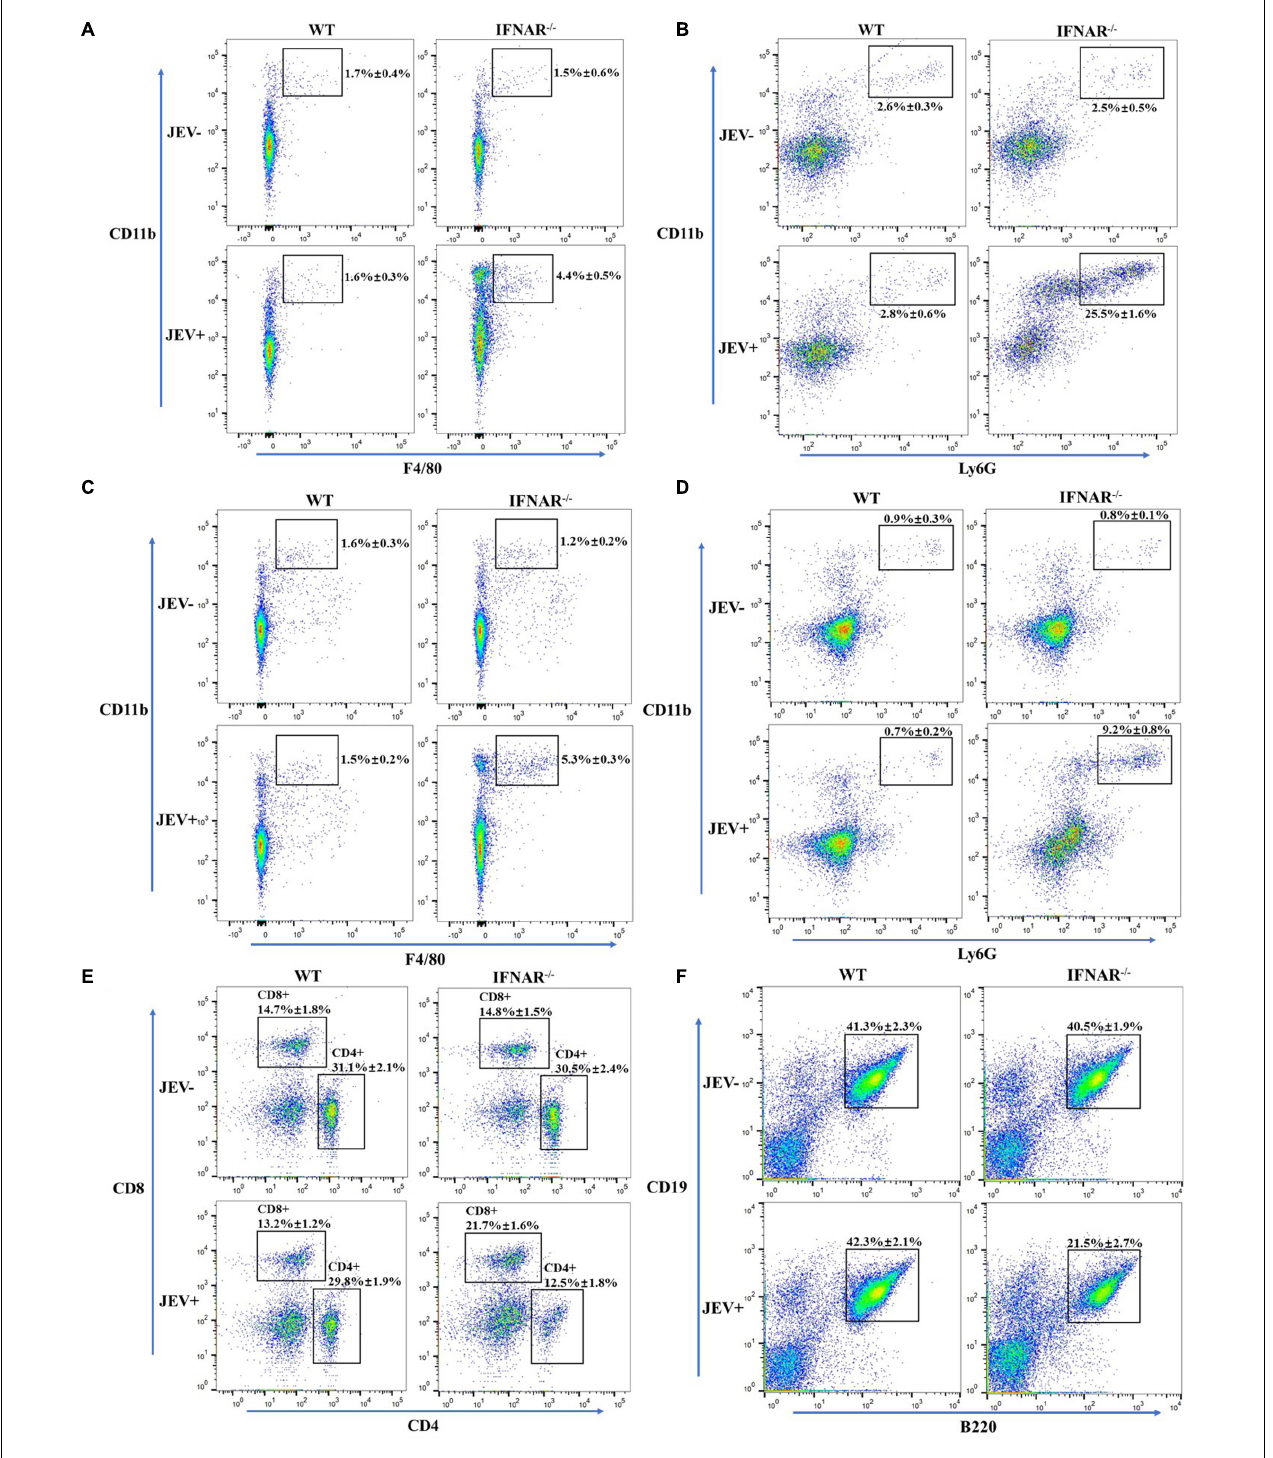
FIGURE 7 | Inflammatory cells infiltrate the liver and spleen in response to the SA14-14-2 strain. Flow cytometry was performed on cells isolated from the liver and spleen of SA14-14-2 strain infected IFNAR − / − mice at 4 dpi. (A,B) The populations of F4/80 + CD11b macrophages (A) and Ly6G + CD11b neutrophils (B) were significantly increased in the liver of infected IFNAR − / − mice. (C,D) The populations of F4/80 + CD11b macrophages (C) and Ly6G + CD11b neutrophils (D) were significantly increased in the spleen of infected IFNAR − / − mice. (E,F) The populations of CD4 + T and B cells were significantly decreased, and the population of CD8 + T was significantly increased in the spleen of infected IFNAR − / − mice. All the data represent mean ± SD of biological triplicates from at least three independent experiments.